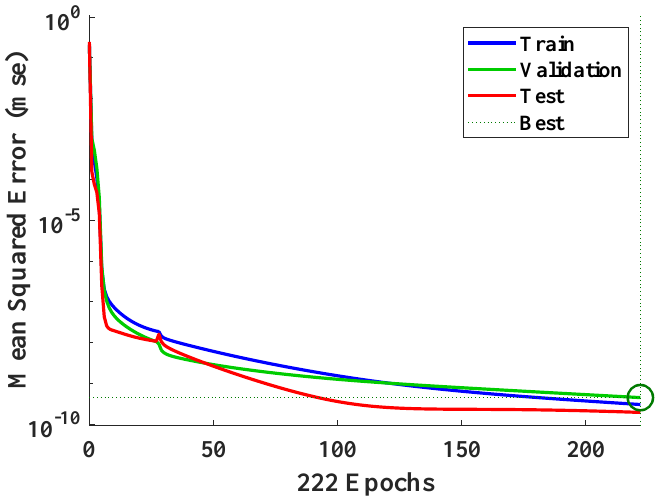
Figure 5. Validation of the Nonlinear ARX network’s performance.